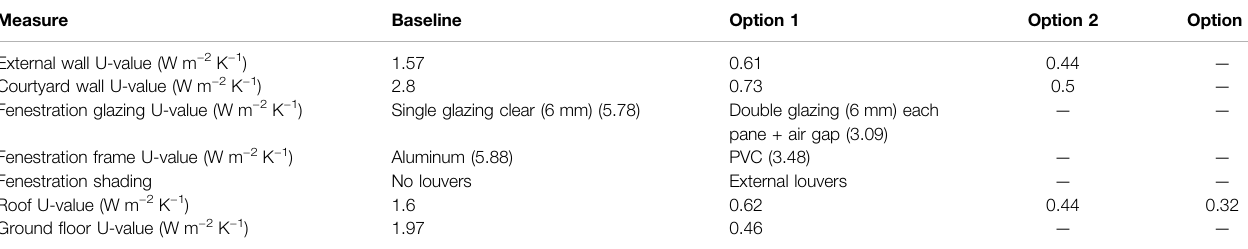
TABLE 1 | Passive measure options considered for the case study